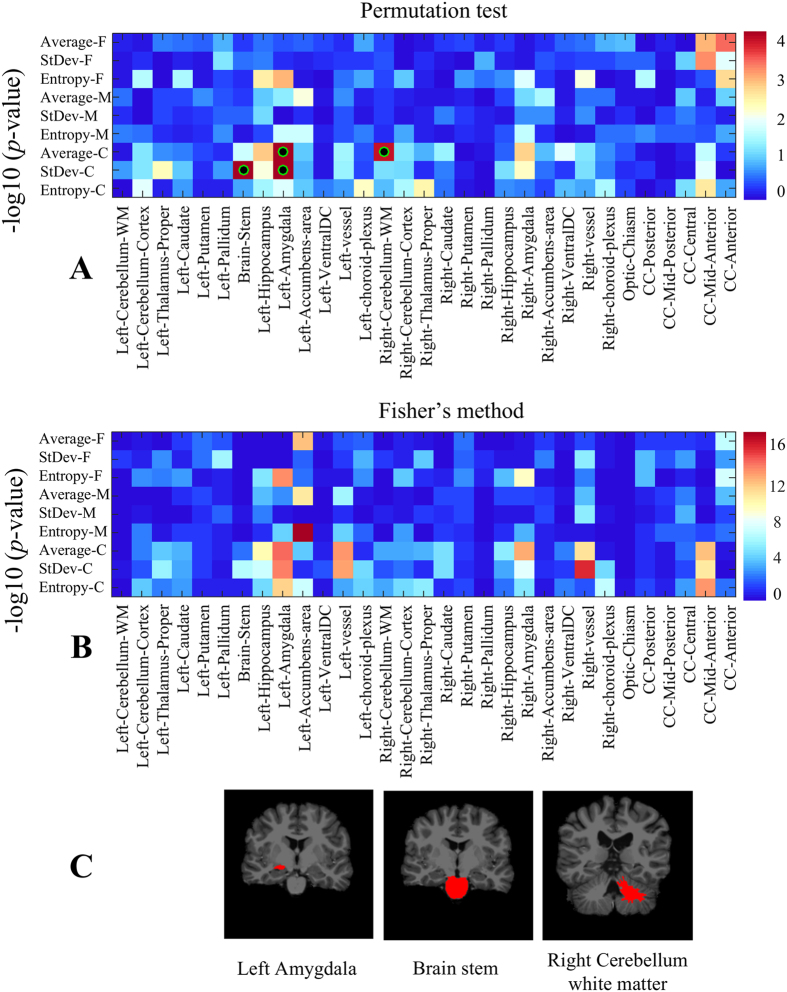
Region-wise texture feature differences between male and female TDC subjects.(A) Heatmap of uncorrected p-values (-log10 space) based on 100,000 permutations of sex labels. Green-black circles indicate region-scale values with significant p-values following Holm-Bonferroni correction. (B) Heatmap of Fisher’s method p-values (−log10 space), based on 100 bootstrap samples of 50 males vs 50 females. (C) Regions showing significant texture differences with corrected p < 0.05.